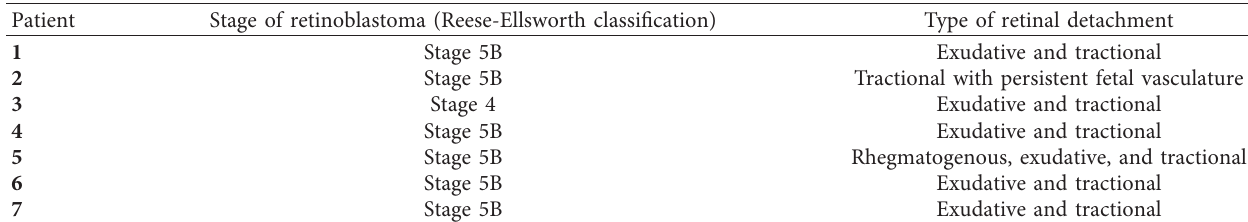
Table 2: Stage of retinoblastoma and type of associated retinal